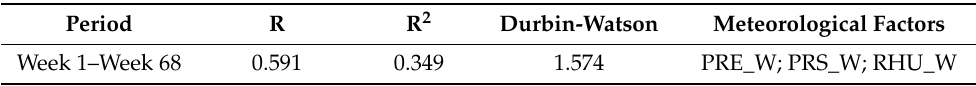
Table 6. Multiple linear regression analysis of meteorological factors and NAIs from 69